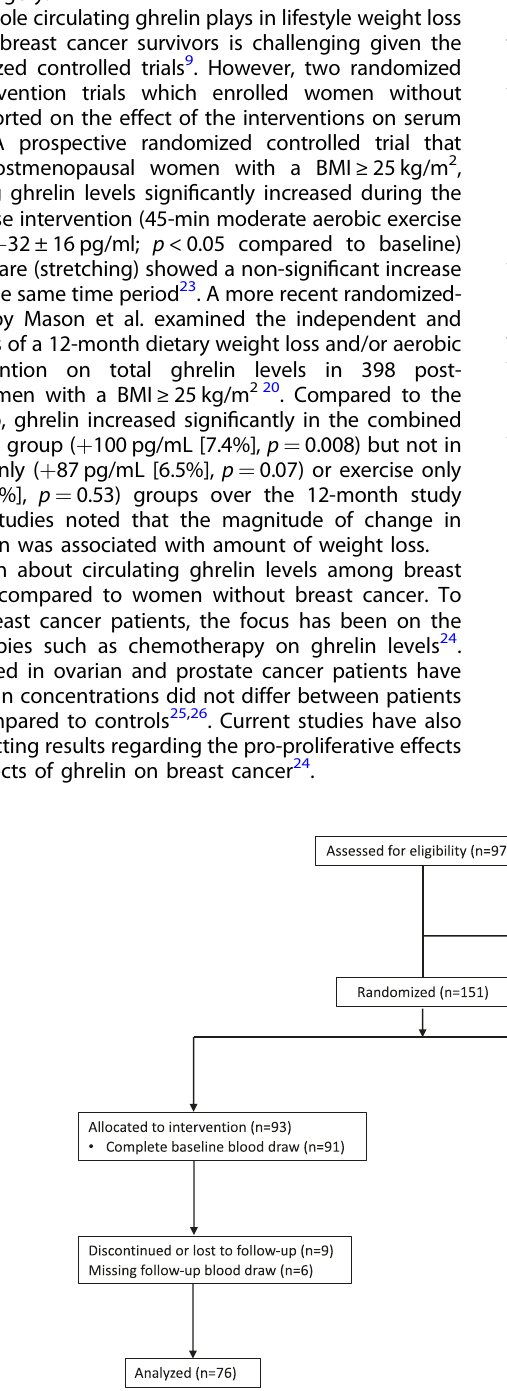
Fig. 1 Consort diagram. Flow diagram of individuals enrolled in the lifestyle, exercise and nutrition (LEAN)